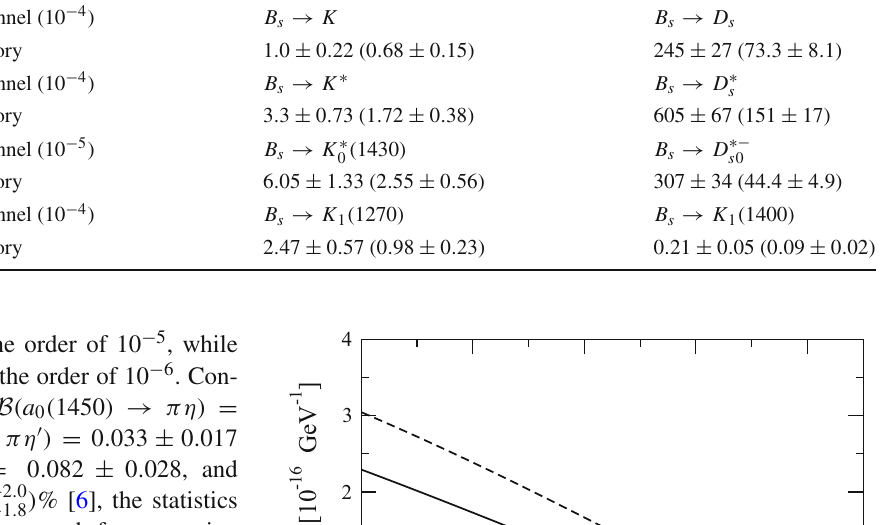
Table 7 Same as Table 5 but for the B s decays, with the numbers Channel (10